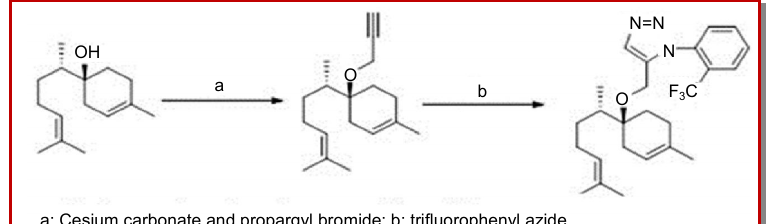
a: Cesium carbonate and propargyl bromide; b: trifluorophenyl Figure 1: Chemical synthesis of trifluoromethyl-phenyl triazolyl derivative of beta-bisabolol